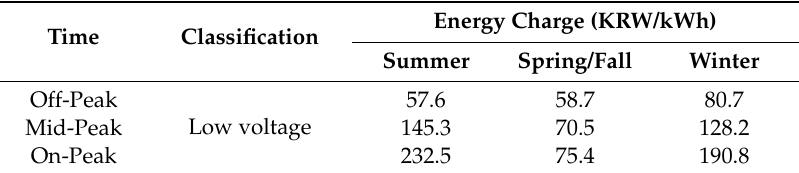
Table 3. Electric vehicle charging tariff [16].